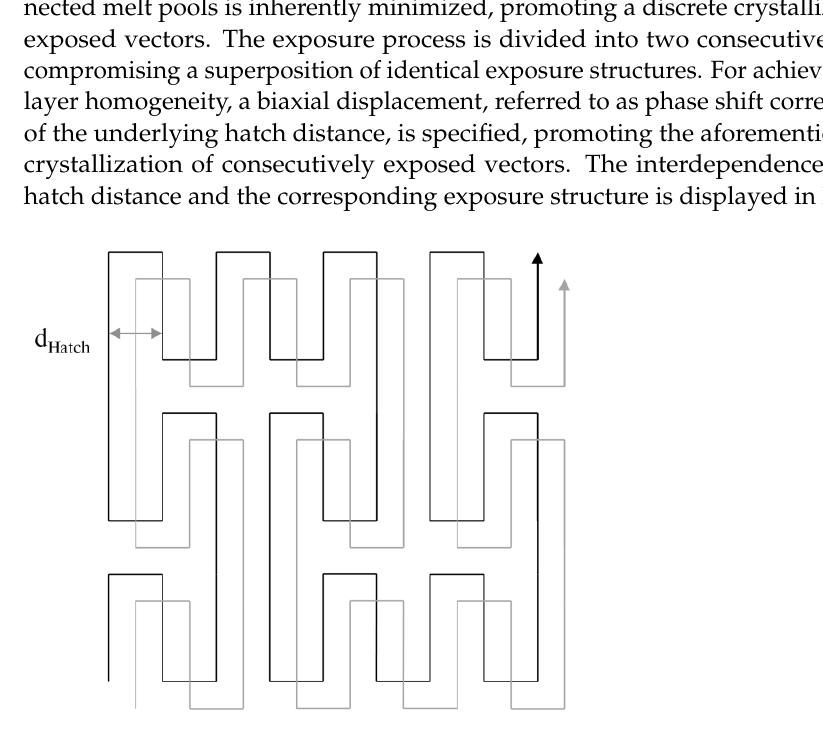
Figure 1. Schematic depiction of the local structure of superposed, fractal exposure structures based on the space-filling Peano